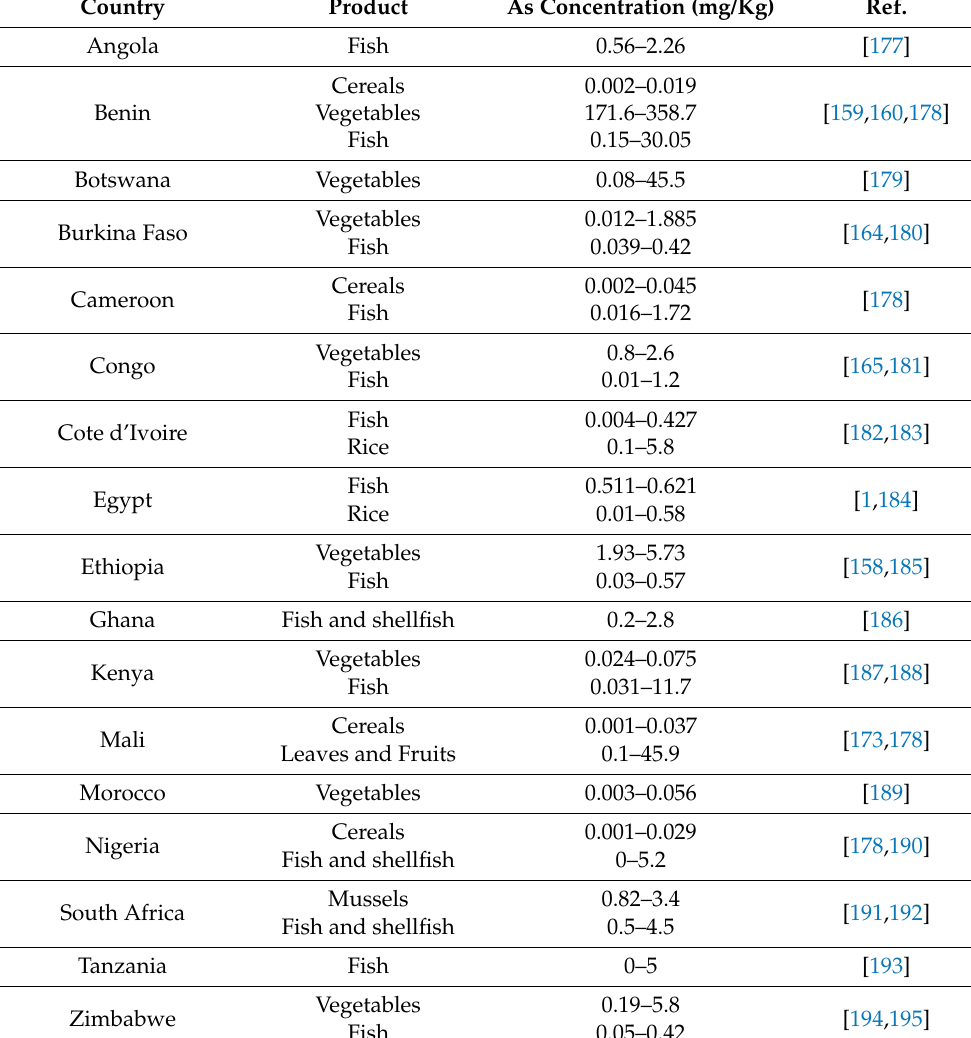
Table 9. Foods affected by arsenic contamination in Africa regions (selected data from recent